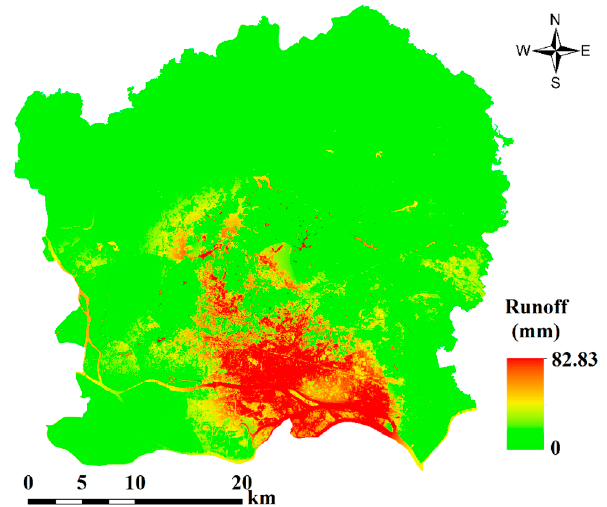
Figure 16. Spatial distribution of simulated surface runoff at 1 p.m., 4 May 2015.